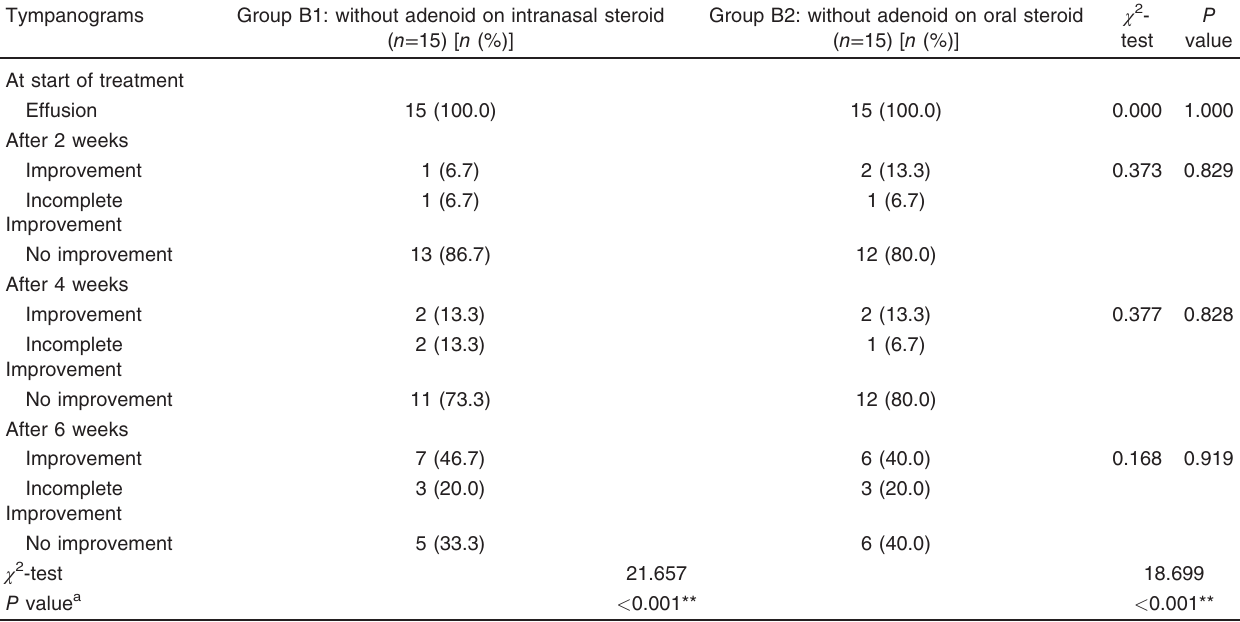
Table 8 Comparison between group B1, without adenoid on intranasal steroid, and group B2, without adenoid on oral steroid according to tympanograms Tympanograms Group B1: without adenoid on intranasal steroid ( n = 15) [ n (%)]